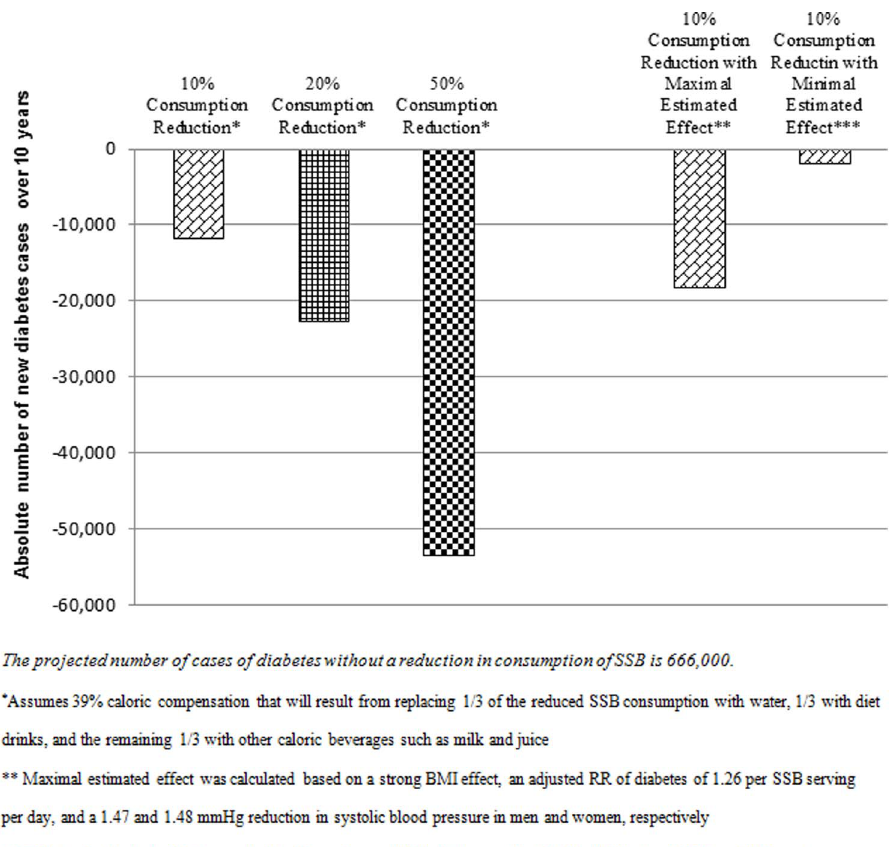
Figure 2. Projected incident diabetes decrease at different levels of SSB consumption reduction with variation of BMI effects.